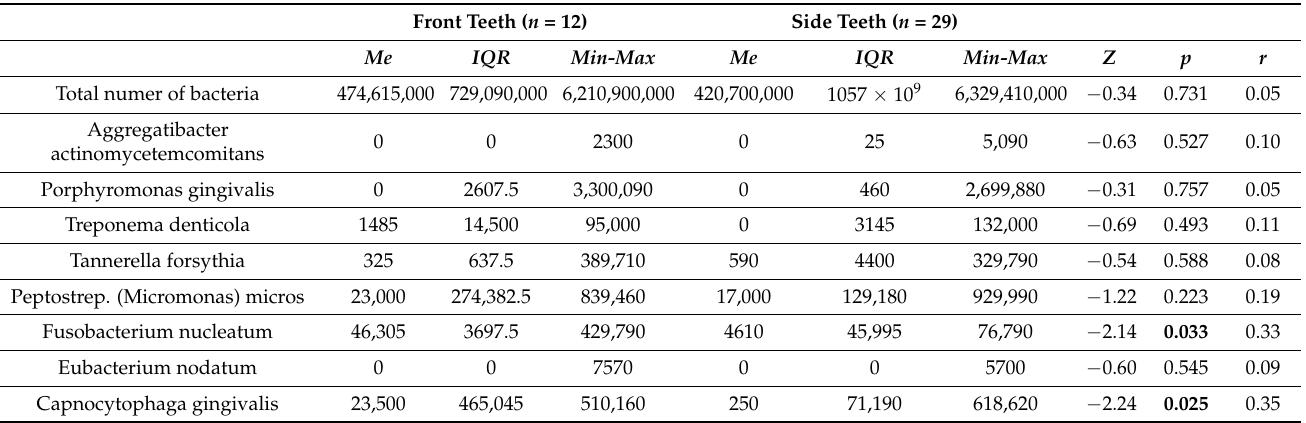
Table 7. The difference in the number of bacteria between measurements (i.e., before and after treatment with a bioactive healing abutment containing clindamycin) in patients with front and side teeth implants.